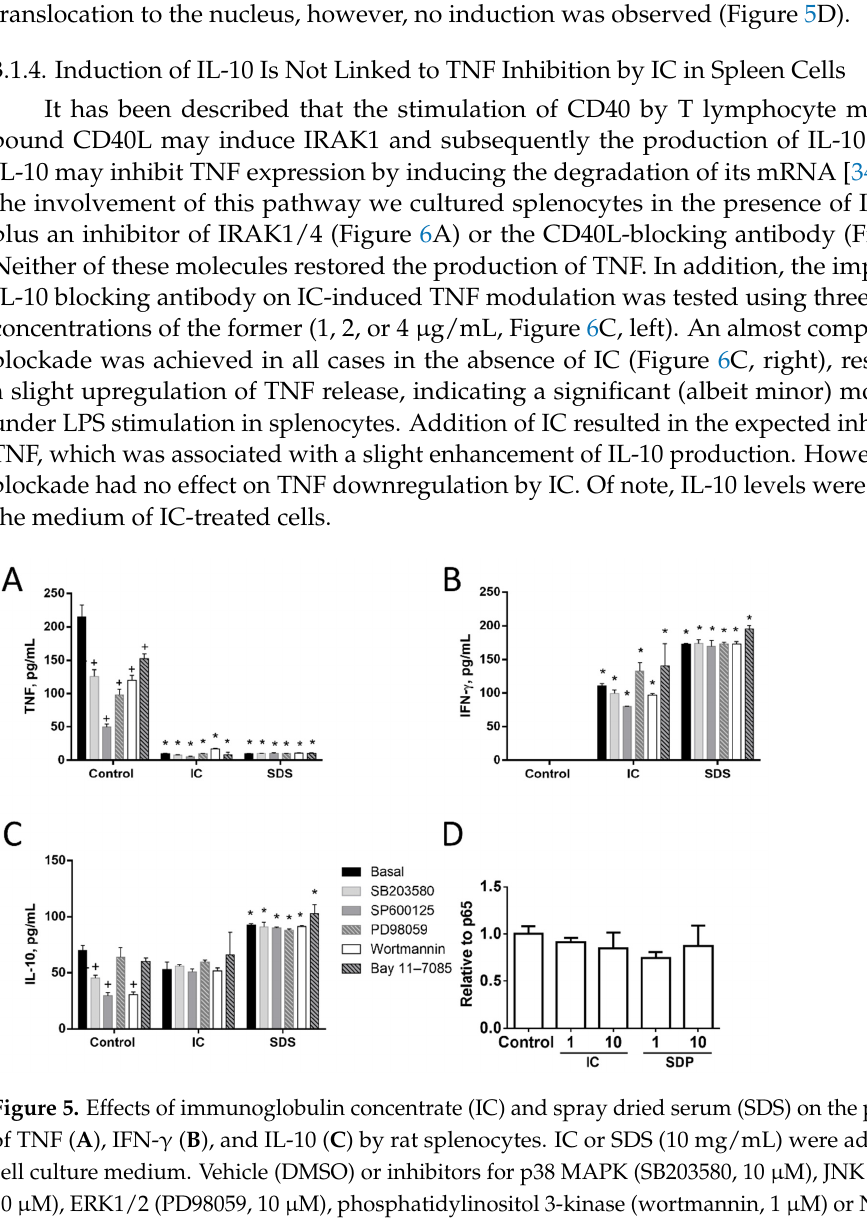
Figure 6. Involvement of IL-10 on the inhibition of TNF production by immunoglobulin concen- trate (IC) and spray dried serum (SDS) in rat splenocytes. ( A ) Effect of NF- κ B and IRAK1/4 inhib- itors on TNF production. Bay 11-7082 (10 µM) and the IRAK 1/4 inhibitor 1 (10 µM) were added to the cell culture medium together with SDS and IC for 48 h. ( B ) Effect of a blocking anti-CD154 antibody on TNF production, following the same protocol. ( C ) Effect of a blocking anti-IL-10 an- tibody (1, 2 or 4 µg/mL) on TNF and IL-10 secretion, following the same protocol. ( D ) Evaluation of IC immunoreactivity by rat IL-10 ELISA and blockade by rat anti-IL-10 antibody. IC (10